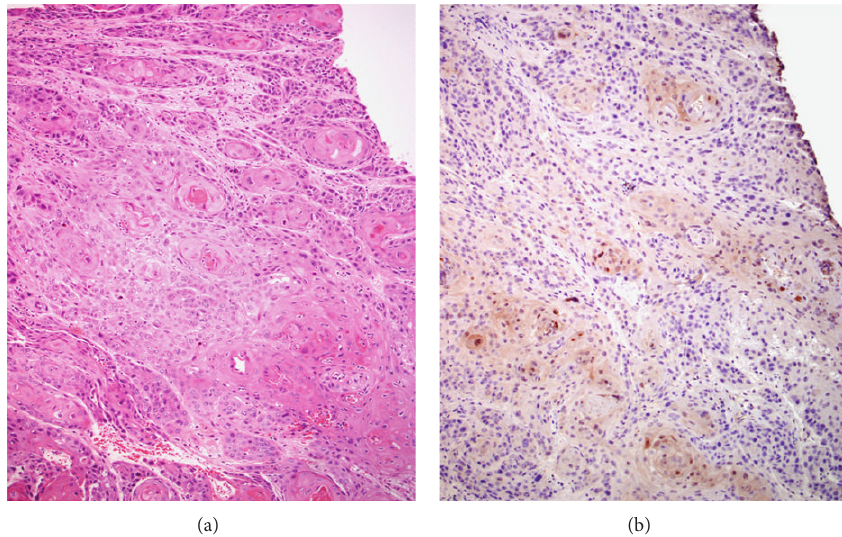
Figure 2: H&E (a) and CALML3 immunostained (b) sections of invasive squamous cell carcinoma under low power light microscopy (100x). An appreciably diminished, and in many areas, absent immunoreactivity is seen in invasive squamous cell carcinoma.